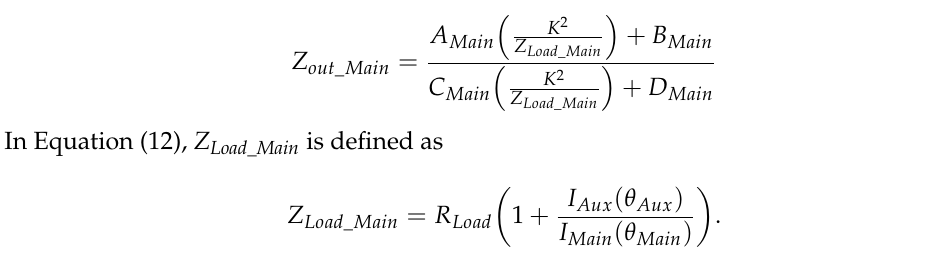
Figure 8. The half circuit equivalent for the Main Amplifier section of the Doherty Amplifier.